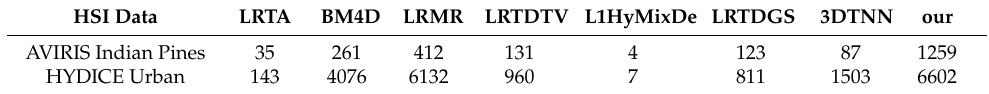
Table 6. The running time (in seconds) of the different methods in the real HSI dataset experiments. HSI